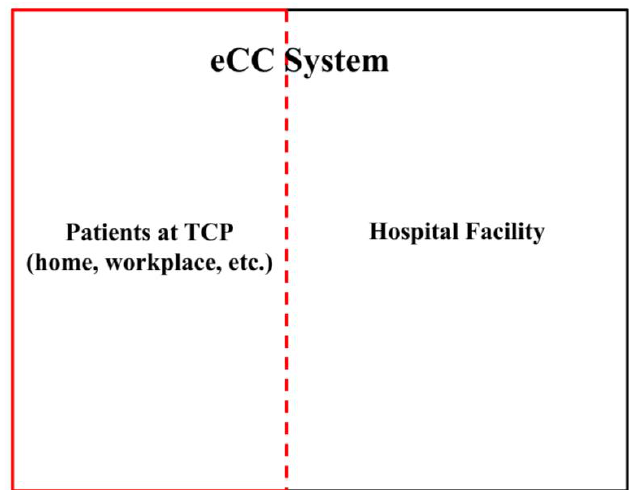
Figure 1. Aggregate view of an electronic companion care (eCC) system. TCP: transitional care period.